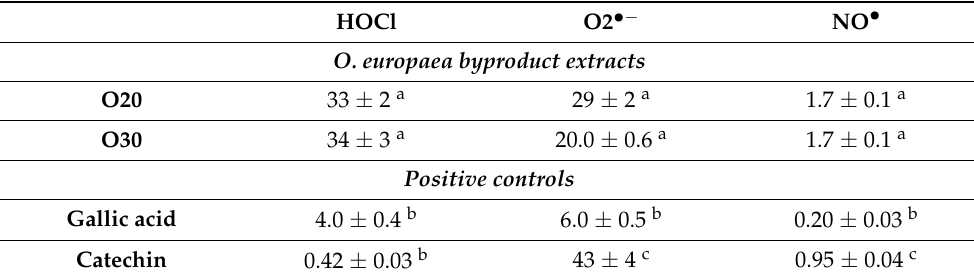
IC 50 = In vitro concentration required to reduce the reactivity of the tested reactive species by 50% (mean ±